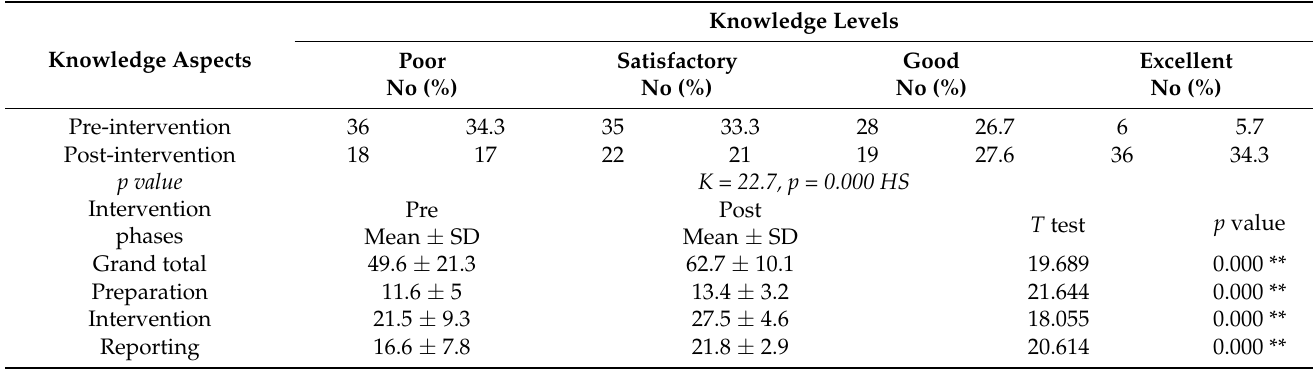
Table 4. The effectiveness of standardized protocol for oxygen medical aid on participating nurses’ knowledge & performance pre- and